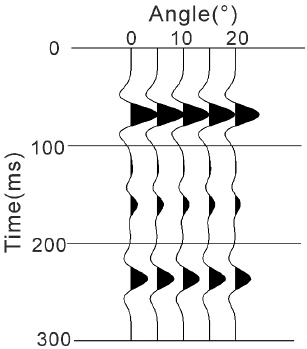
Table 2. Parameters of multi-layer models. Units of velocities, densities and thickness in Table 2 are m/s, g/cm 3 and m, respectively.